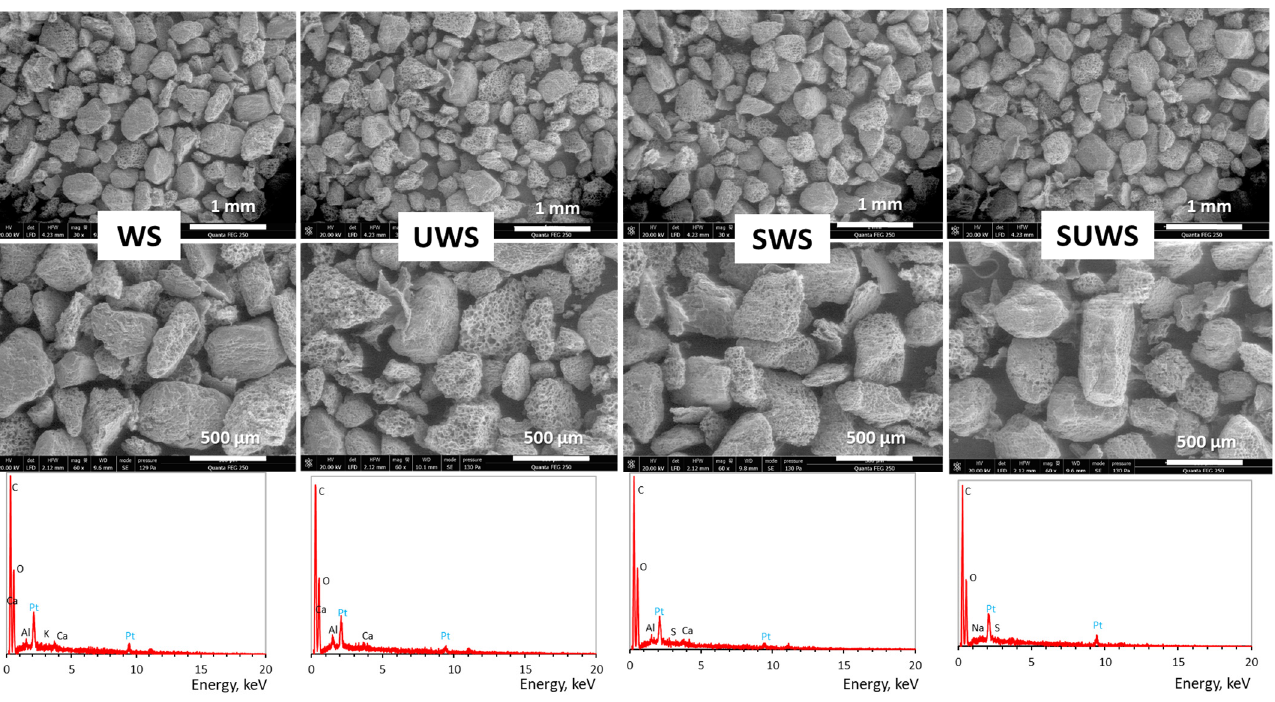
Figure 3. SEM micrographs and EDX analysis of biosorbents.